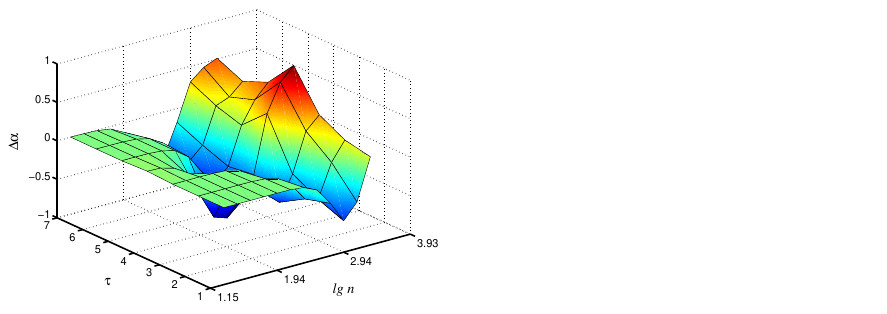
Figure 3. Differences ∆ α in local values of α for synchronous and asynchronous chaotic oscillations studied for the fast mode of the first nephron.